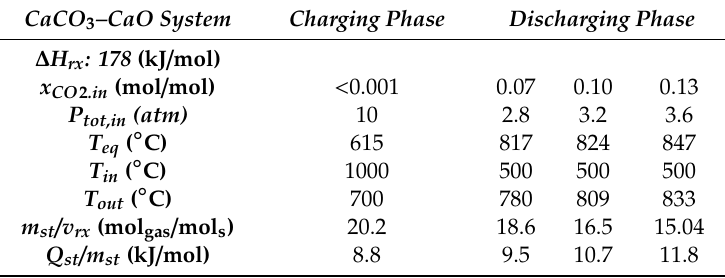
Table 8. TCS operating conditions for the carbonate-based system (CaCO 3– CaO) applied to an open loop process: in the discharging phase, three possible scenarios are analyzed, associated to three different CO 2 concentrations of the inlet gas flow.